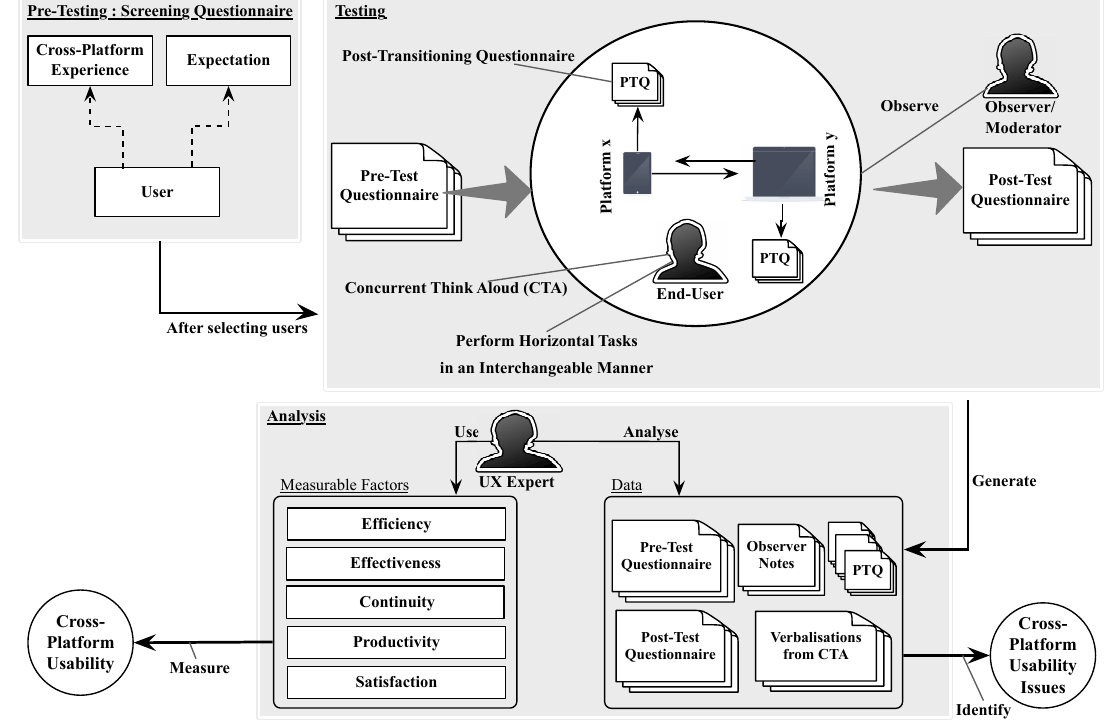
Figure 5. The refined cross-platform usability assessment